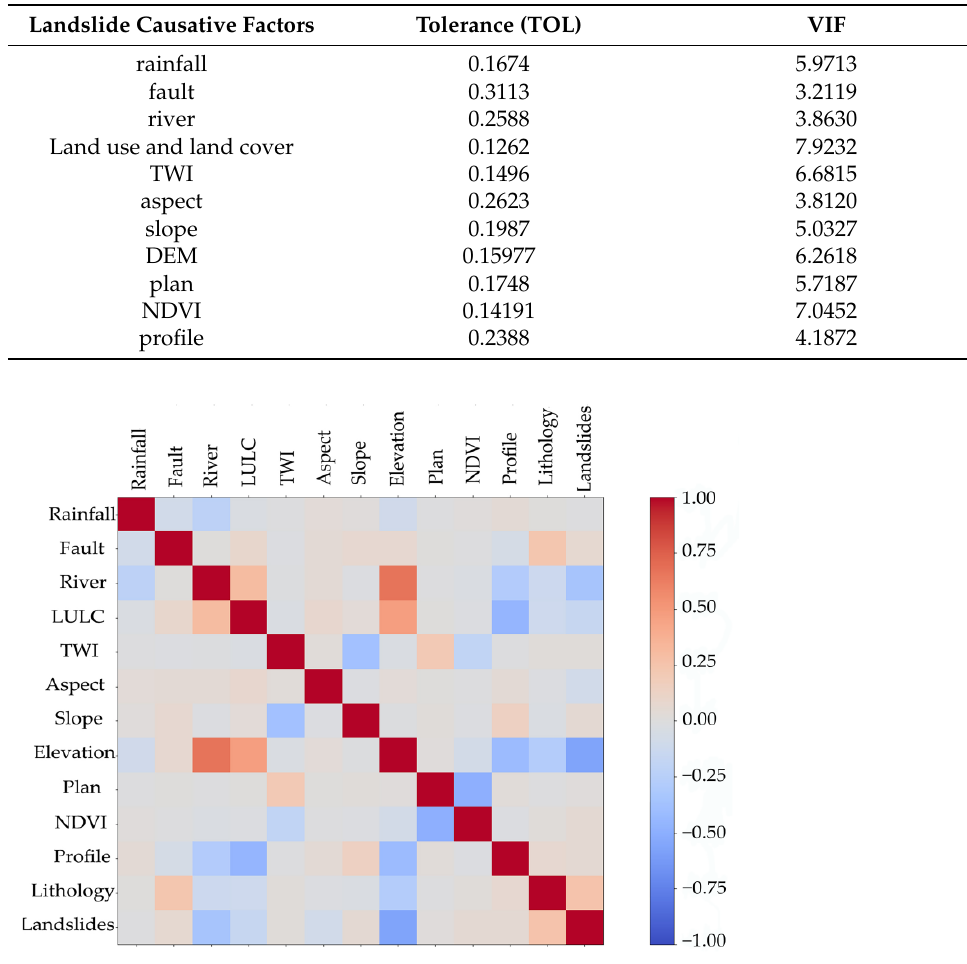
Figure 6. Landslide factor categories and correlation for landslides. The horizontal and vertical axes indicate the landslide image factor, and the heat map indicates the magnitude of the correlation. (‘ls’ indicates landslides and non-landslides). The color bar on the right indicates the correlation value (from − 1 to 1).